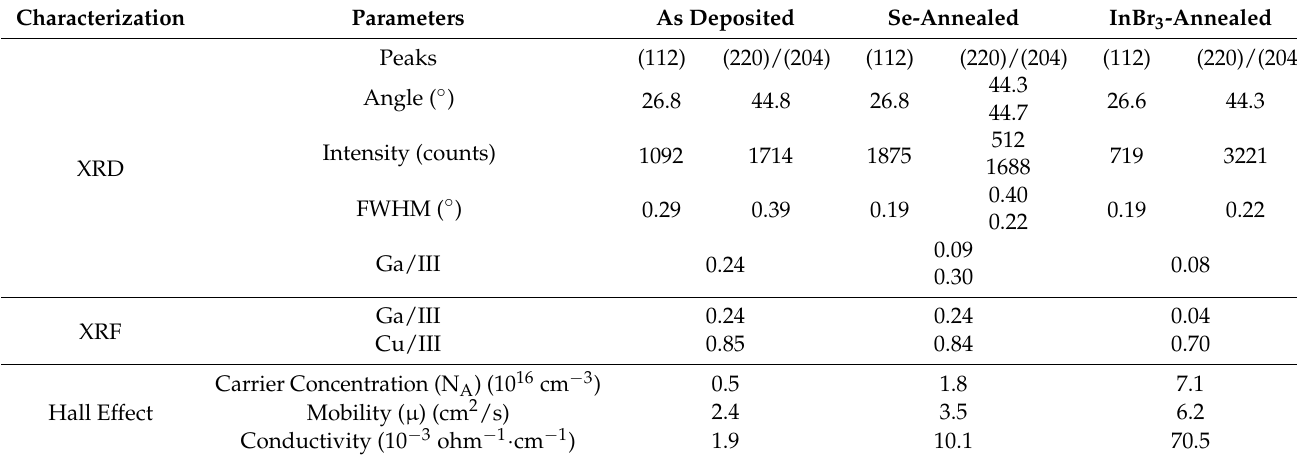
Table 2. XRD data analysis, XRF, and Hall effect measurements for the samples annealed at 500 ◦